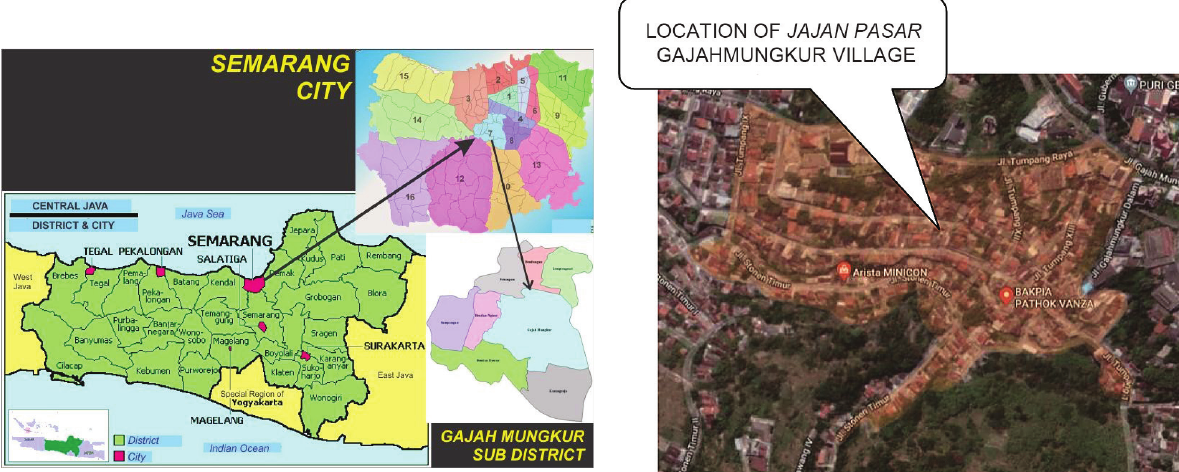
Figure 1. Location of Gajah mungkur Administrative Village and Jajan Pasar Village